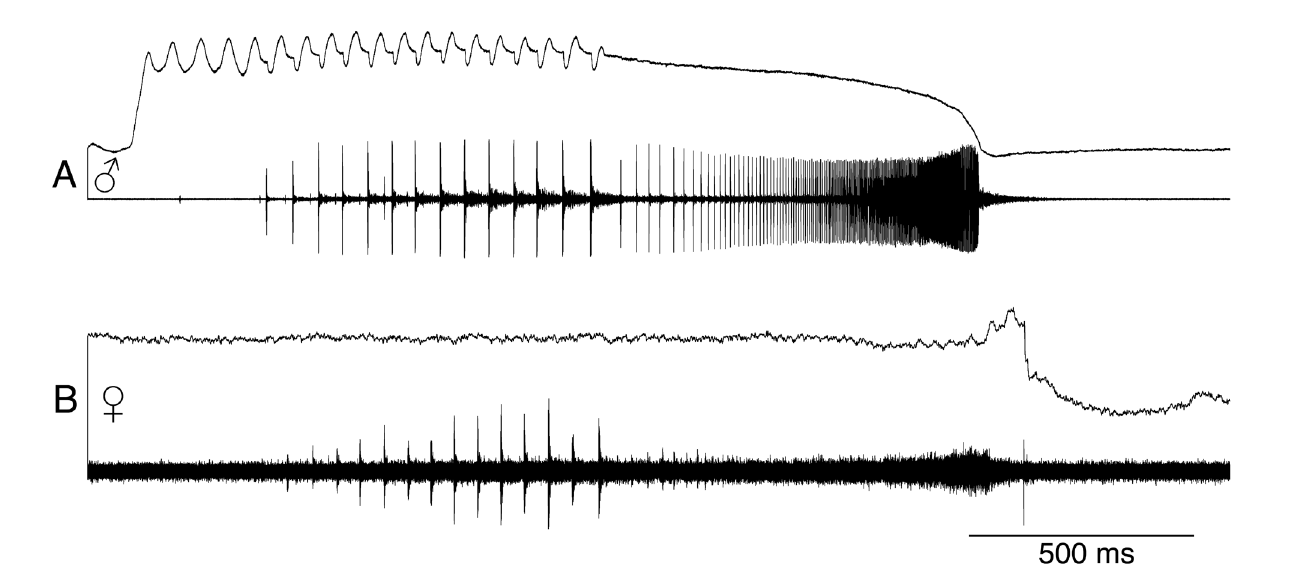
Figure 16. Male calling song A. and female response B. of Ectadia fulva . Oscillograms of stridulatory movement and song [synchronous registration of left tegmen movement and sound (upper line: upward deflection represents opening, downward closing; lower line: sound)]. Male and female were recorded